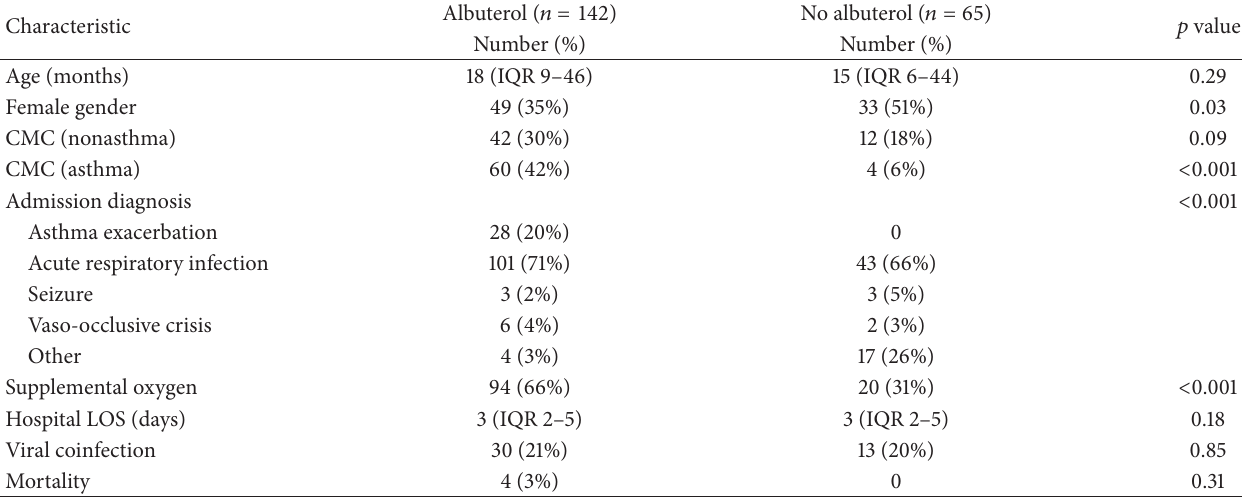
Table 2: Characteristics of patients hospitalized with human metapneumovirus infection stratified by receipt of albuterol.